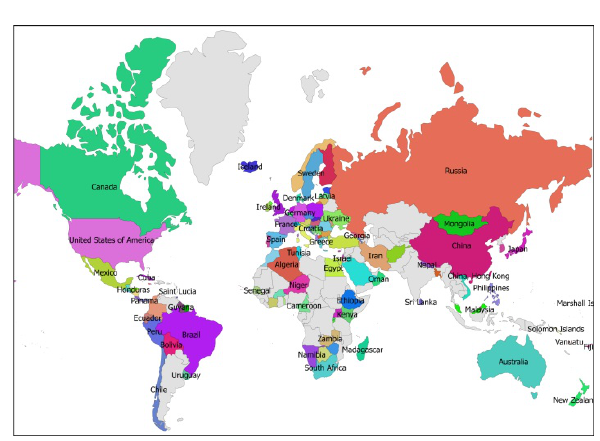
Figure 1: 115 countries have replied the Questionnaire until June 2015 (not all country names are visible